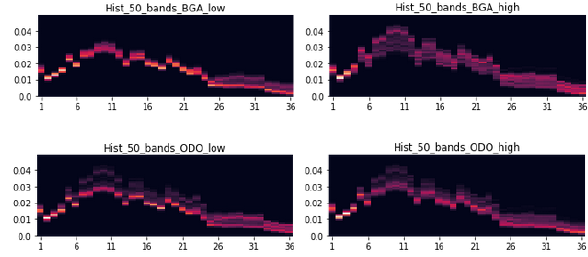
Figure 3. Spectral reflectance signatures for the low- and high-classes of the parameters BGA and ODO